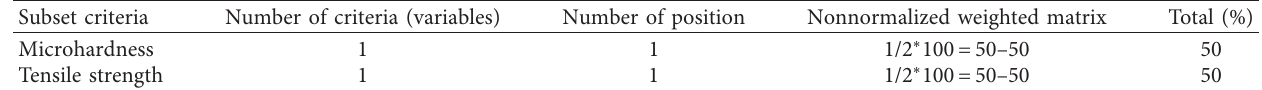
Table 6: Computational steps of Simos weighting